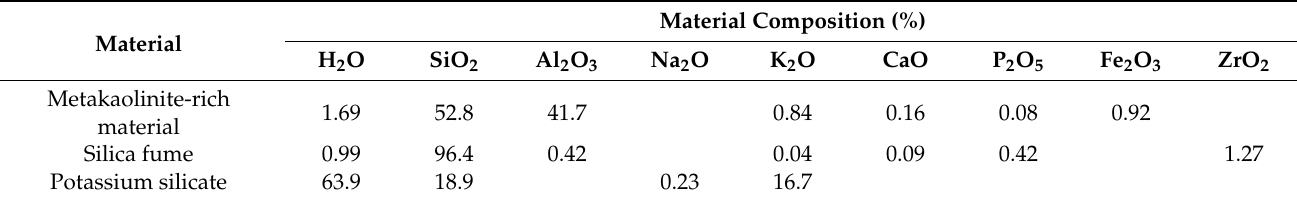
Figure 1. XRD patterns of metakaolinite-rich material and silica fume. Table 1. Chemical composition of raw